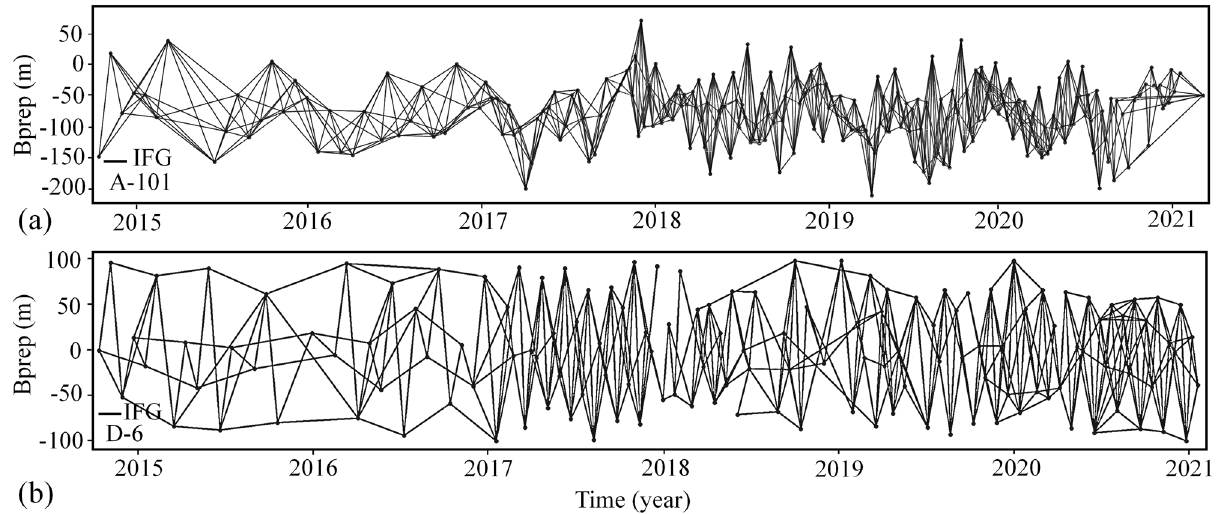
Figure 5. Perpendicular baseline configuration and network of the 453 and 365 interferograms formed from track ( a ) A-101 and ( b ) D-6 S1A images used in the study